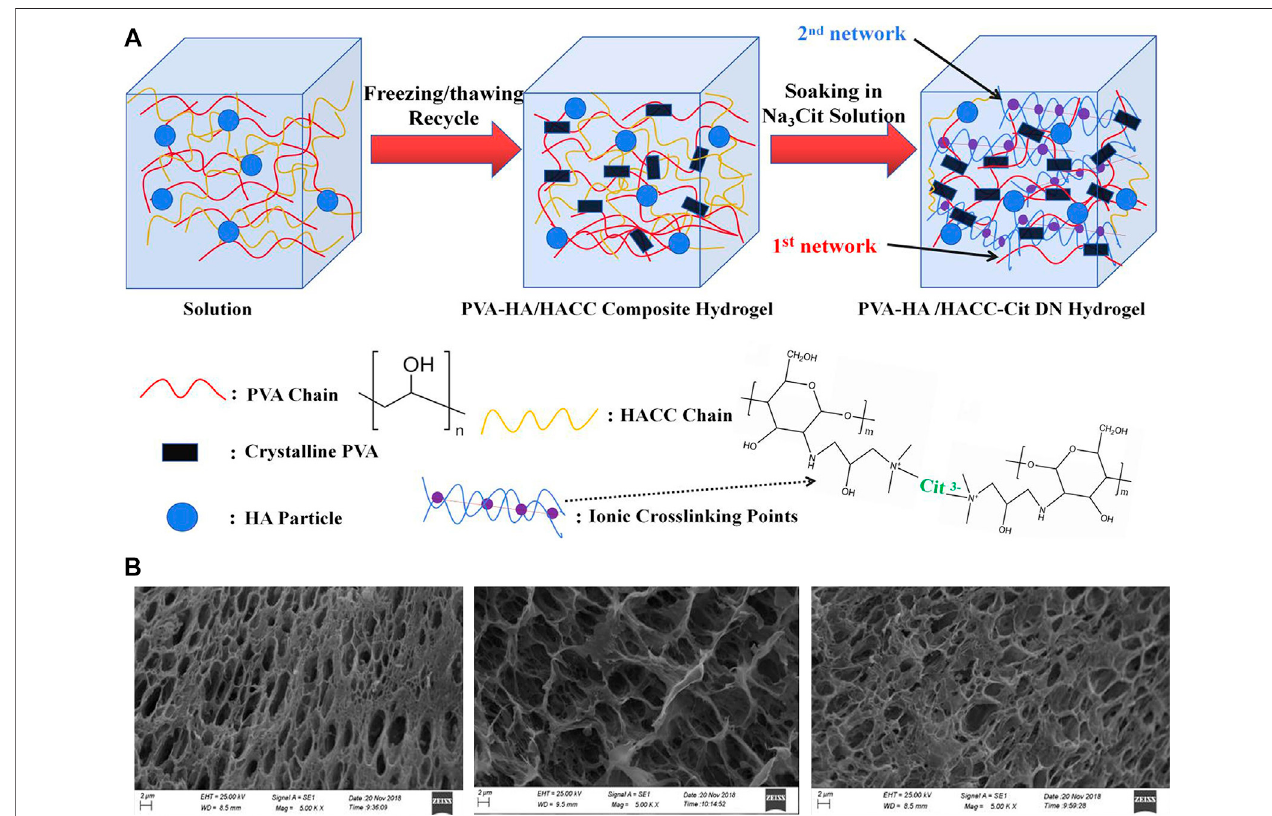
FIGURE 2 | (A) Preparation schematic diagram of the preparation of PVA-HA/HACC-Cit DN hydrogelr; (B) SEM images of the cross-section of composite hydrogels. Reproduced from Gan et al. (2020) with permission from Copyright 2020 Elsevier.